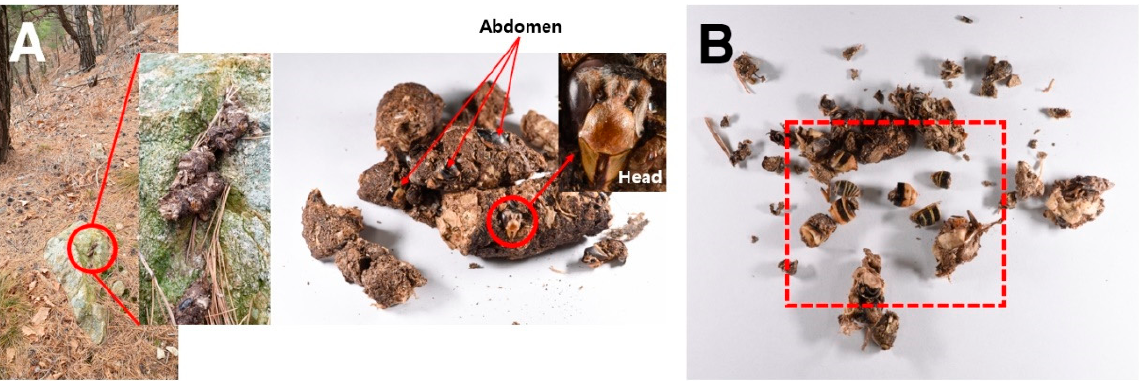
Figure 2. Wasp debris detected in yellow-throated marten (YTM) feces at Mt. Onggangsan. ( A ) Detection of debris of the male head and abdomen of the invasive alien hornet, Vespa velutina nigrithorax (VVN), in YTM feces (feces collection area 1). ( B ) Queen and male debris of Vespula koreensis detected in YTM feces (feces collection area 3).